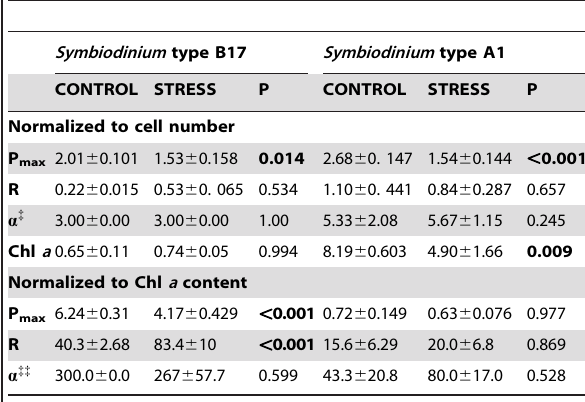
Table 3. Photosynthetic parameters for Symbiodinium cultures exposed to high osmolarity conditions for 7